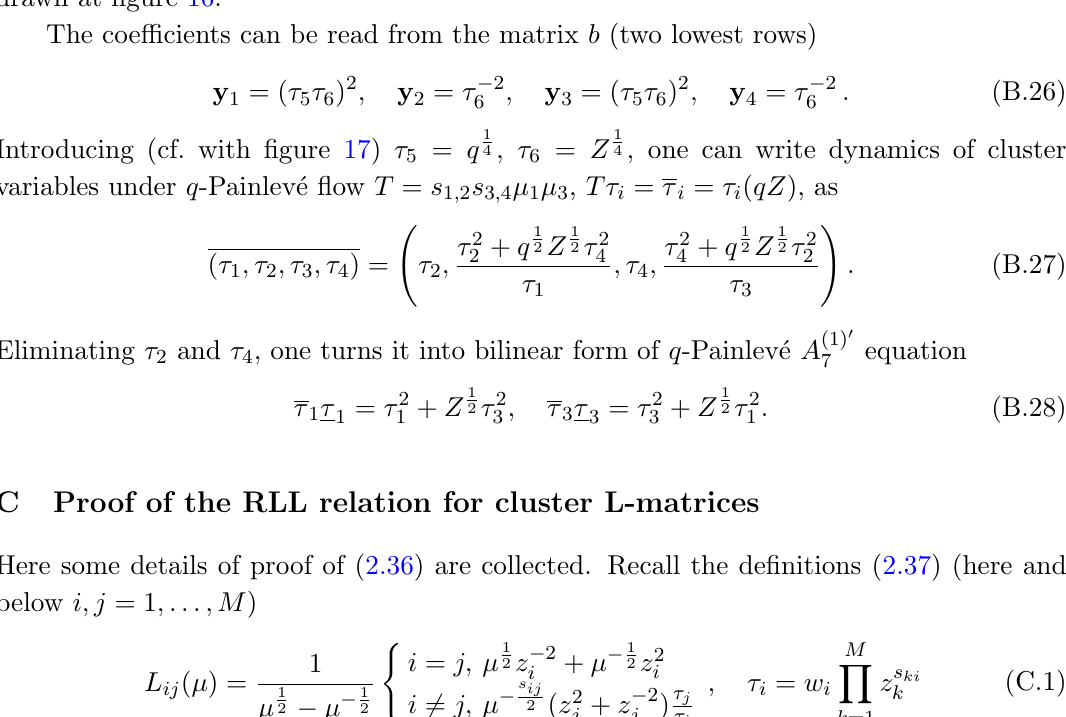
Figure 17 . An example of skew-symmetric matrix " (two-particle Toda chain) and corresponding quiver. Poisson bracket has two Casimir functions Z = x 1 x 3 and q = x 1 x 2 x 3 x 4 . In the example of relativistic a(cid:14)ne Toda chain with two particles (or on two sites) one gets two Casimir functions Z and q . Extended exchange matrix, chosen following [1], is drawn at (cid:12)gure